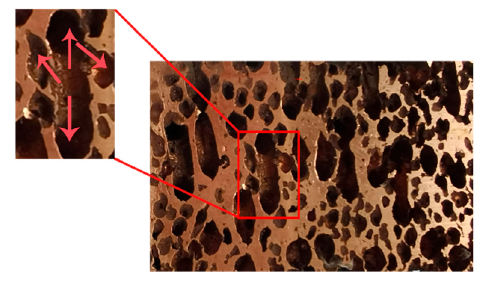
Figure 10. A connecting window of foam copper with a spherical cell.